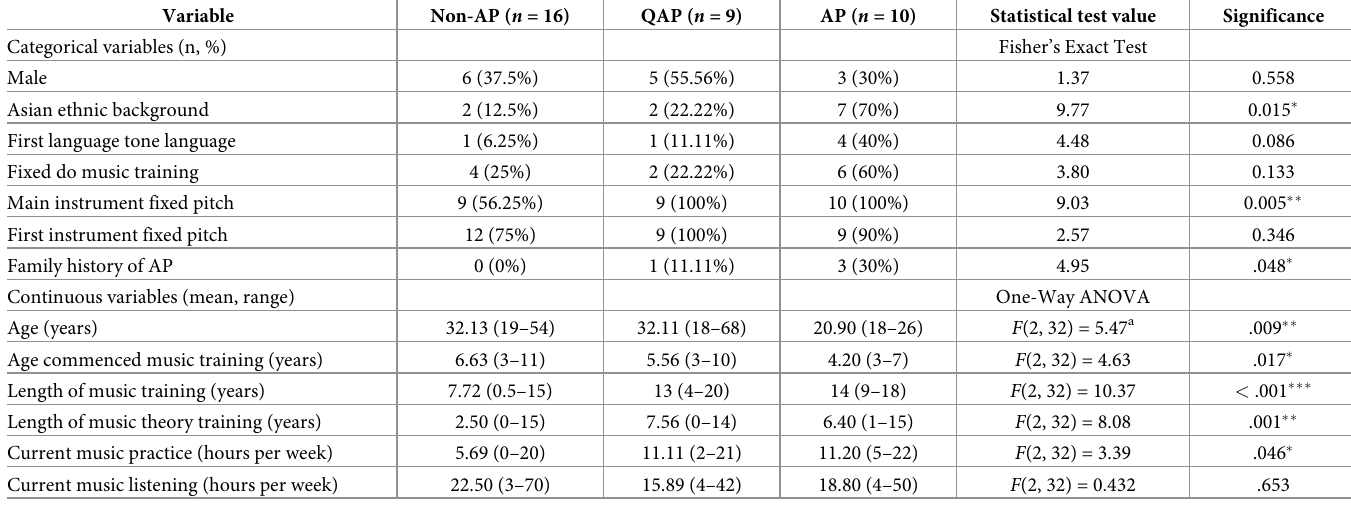
Table 6. Demographic and musical experience differences between